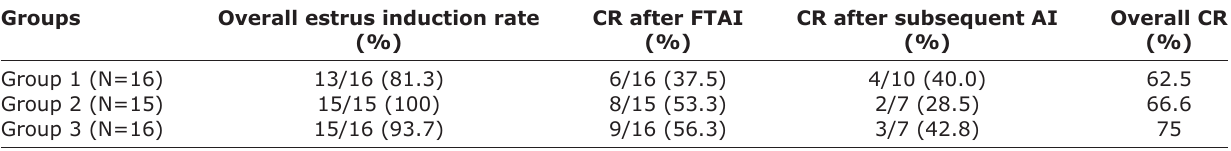
Table-1: CR recorded at FTAI and subsequent AI in buffaloes treated with different protocols during breeding season. Groups